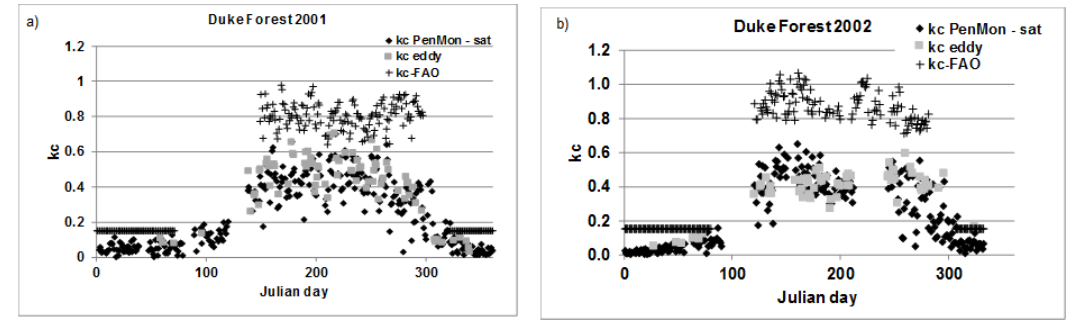
Figure 5. Crop coefficient values for Duke forest eddy covariance station for: ( a ) 2001; and ( b ) 2002.